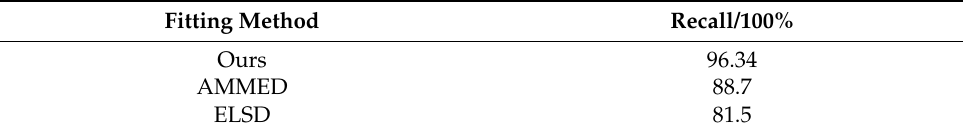
Table 4. Recall test